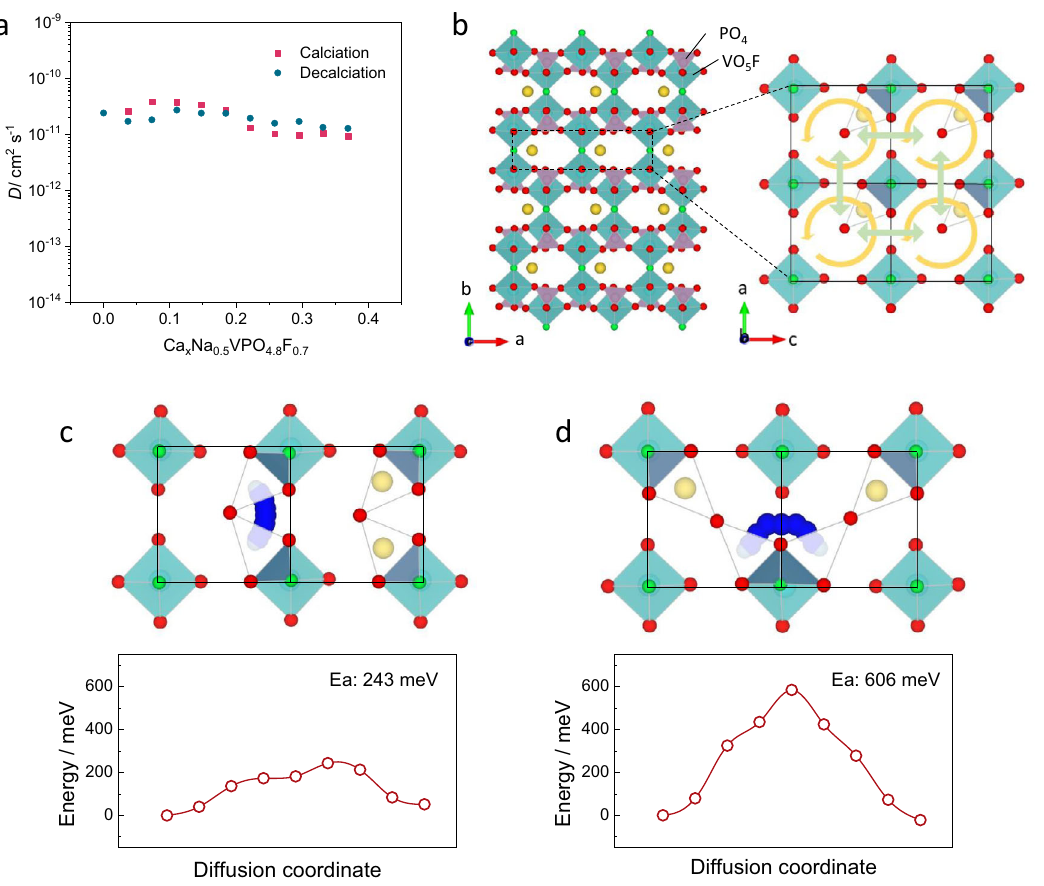
Fig. 4 Kinetic behavior of the desodiated NVPF in CIBs. a Evolution of the diffusion coef fi cient (D) of Ca 2 + in Ca x Na 0.5 VPO 4.8 F 0.7 as a functional the Ca concentration derived from GITT. b Schematic representing the two Ca diffusion pathways in Ca x Na 0.5 VPO 4.8 F 0.7 . Yellow circle arrows and green arrows represent intra-unit and inter-unit paths, respectively. Ca diffusion pathways and diffusion energies for c intra-unit and d inter-unit diffusion. Ca, Na atoms, and VO 5 F octahedral are in blue, yellow balls, and aqua rhombohedron,